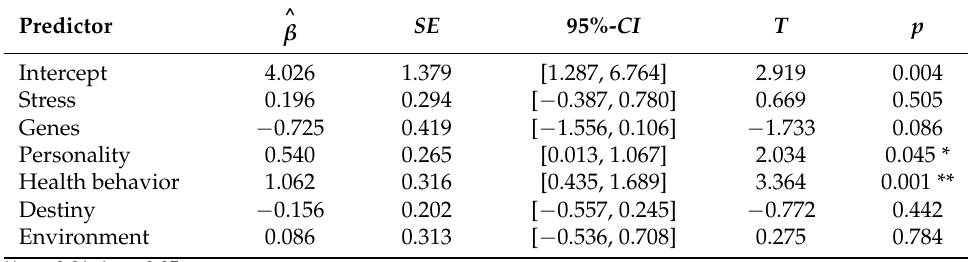
Table 3. Regression of perceived personal control on causal attributions ( N =